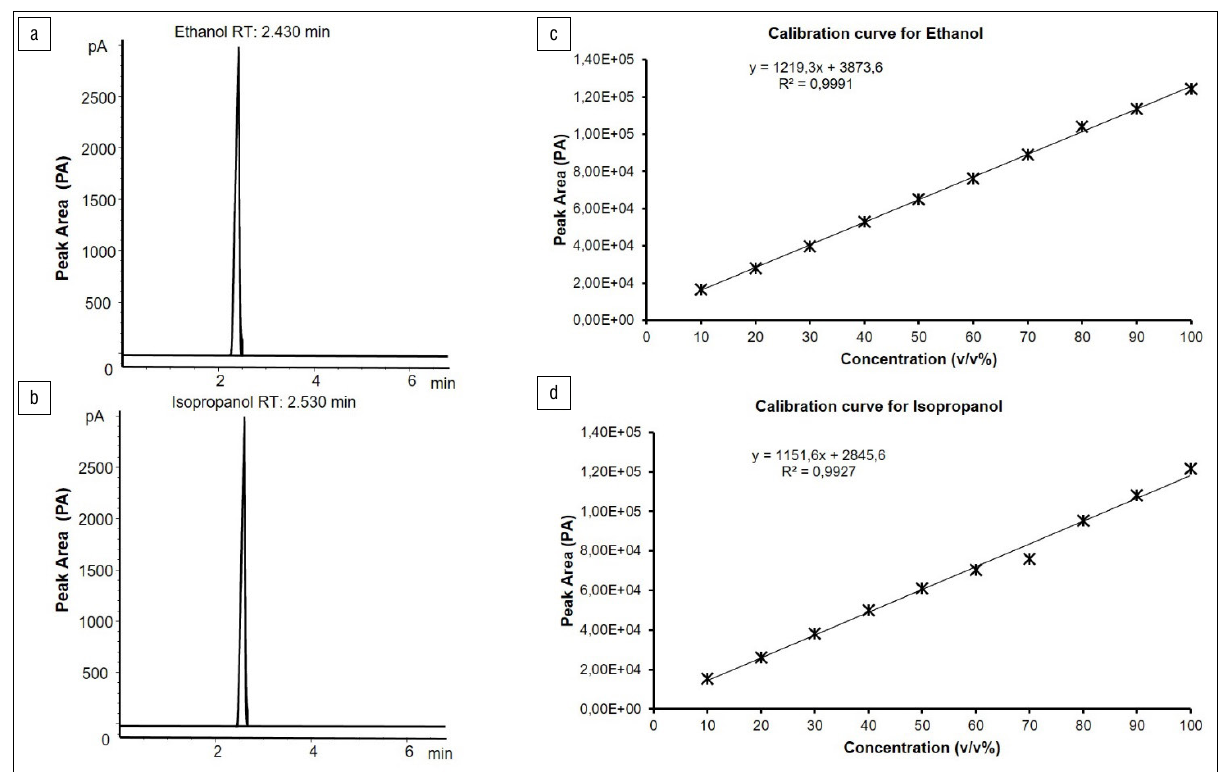
Figure 2: Elution times for ethanol (a) and isopropanol (b) and their respective calibration curves (c and d) indicating the accuracy of detection ( R 2 ) and the regression parameters of the line y=mx+c